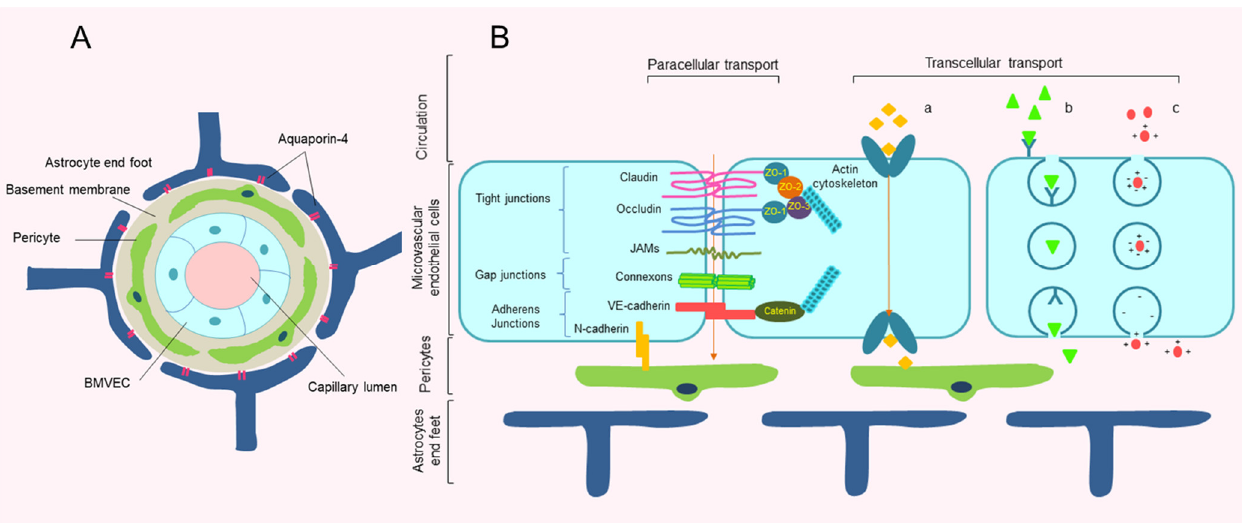
Figure 1. Structure and transportation of metabolites through the blood–brain barrier (BBB). ( A ) Structural component of BBB includes brain microvascular endothelial cells (BMVECs), pericytes, basement membrane, and astrocytic endfeet. ( B ) Mechanism of transport across BBB. Major interendothelial junctions consist of tight junctions, adherens junctions, and gap junctions. Tight junction proteins (TJs) are composed of transmembrane proteins (claudins, occludins) and connecting adhesion molecules (JAM) which contribute to paracellular connection and interaction with zonula occludens (ZO) proteins and actin cytoskeleton. ( a ) Carrier-mediated transport systems (glucose, amino acid exchange); ( b ) specific receptor-mediated endocytosis (insulin exchange); ( c ) adsorptive endocytosis (plasma proteins exchange).